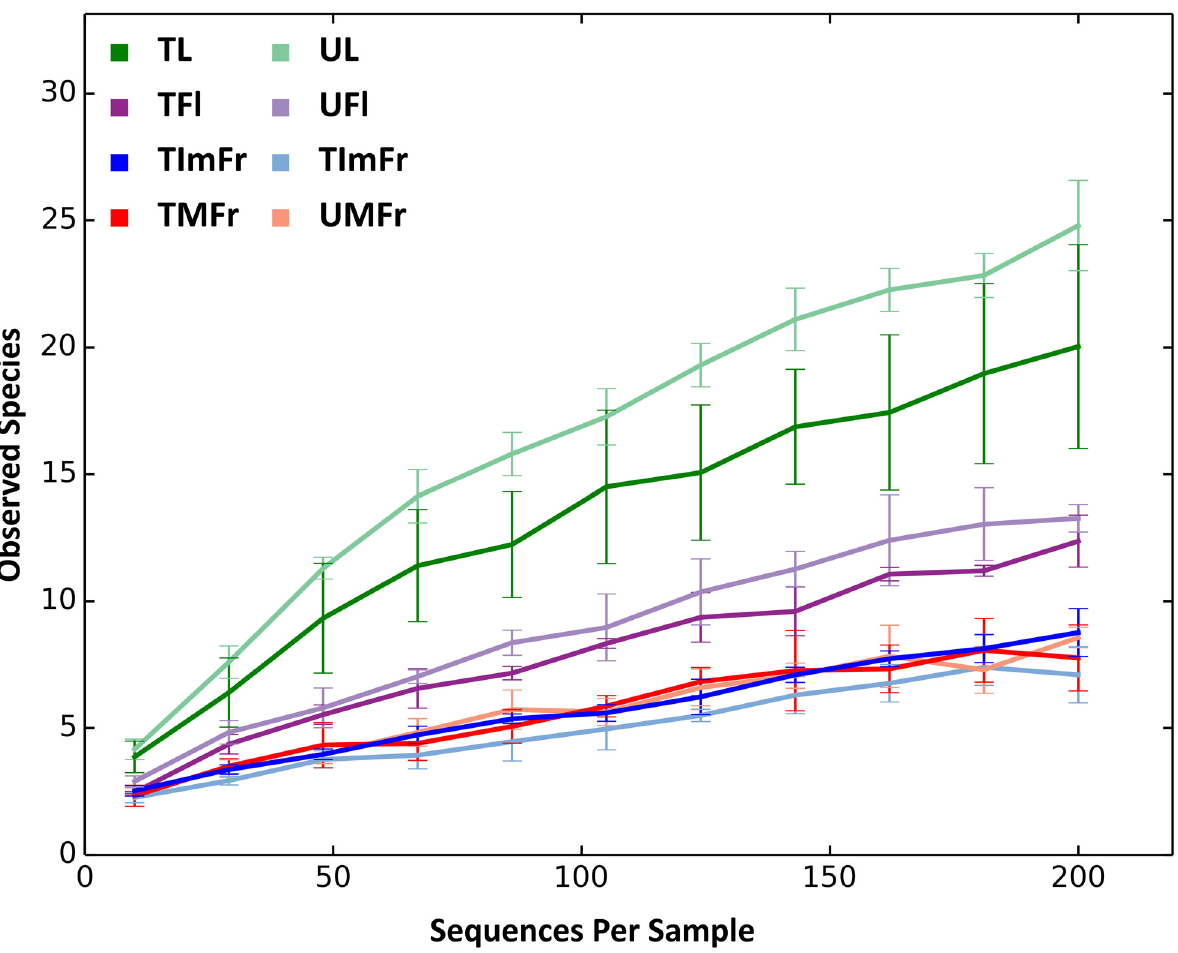
Fig 2. Rarefaction curves of treated (T) and untreated (U) strawberry organs at an even depth of 200 sequences. Samples comprised flowers (TFl and UFl), immature fruit (TImFr and UImFr), leaves (TL and UL), and mature fruit (TMFr and UMFr). Rarefaction curves were grouped to collapse the 3 biological replicates of each analyzed sample